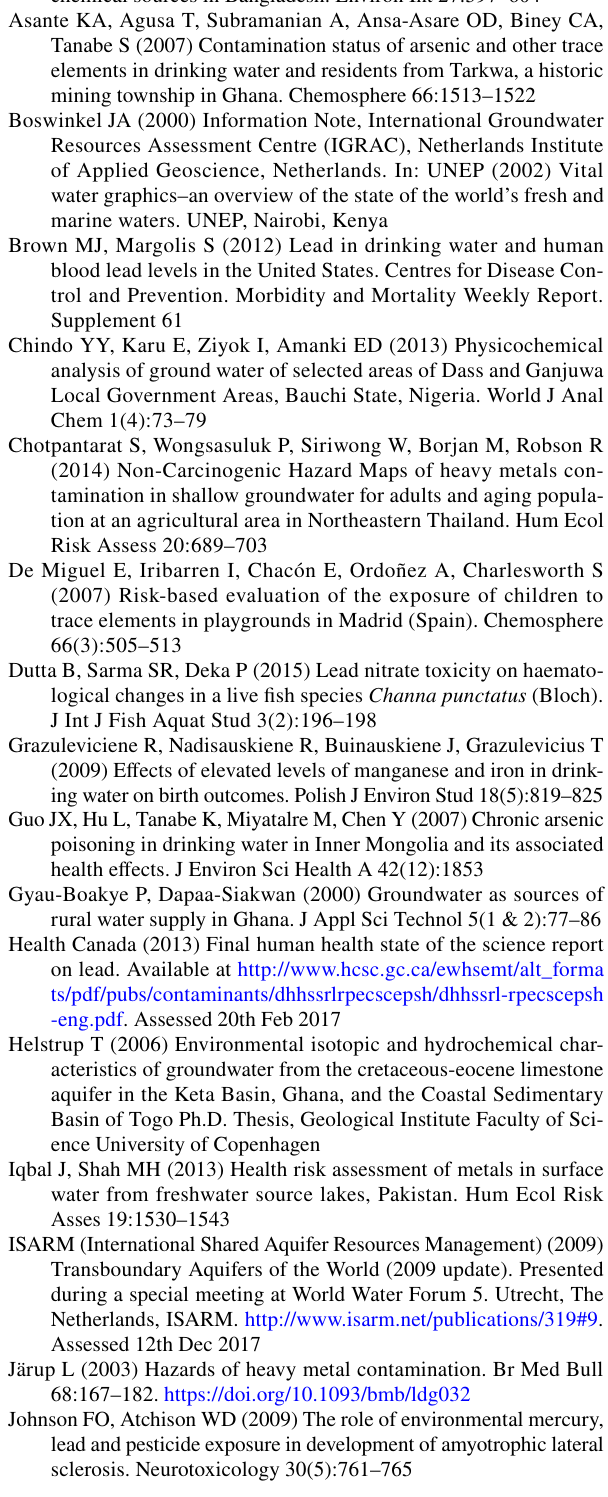
Table 6 Carcinogenic health risk for heavy metals in the well water samples from the Anloga community through oral